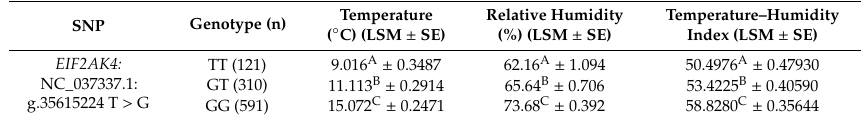
Table 1. Least squares mean and standard error for the temperature (T), relative humidity (RH),